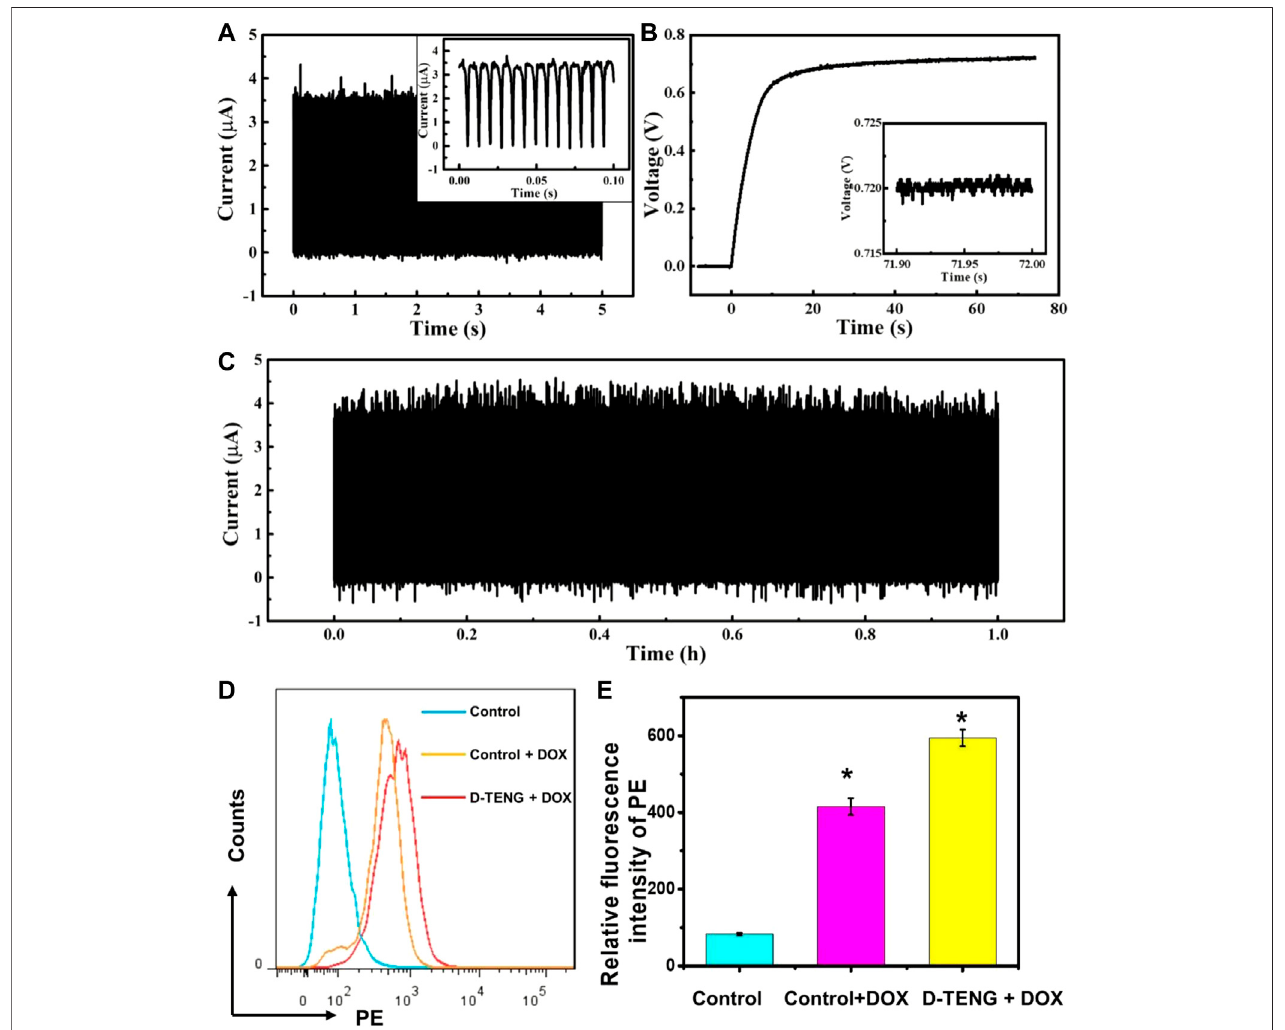
FIGURE5| Invitro enhancingdrug utilization ef fi ciency. (A) The current transmittedto thetailor-madeculture dish. (B) Thevoltage between theAu electrodes. (C) Thecurrentistransmittedtothetailor-madeculturedishinthesimulationprocess. (D) .Theuptakeef fi ciencyof4T1cellsforDoxunder1 hstimulationwasanalyzed24 h after stimulation. (E) Quantitative analysis of (D) . Unpaired t test. n = 3, * p < 0.05, ns represents no signi fi cant difference.